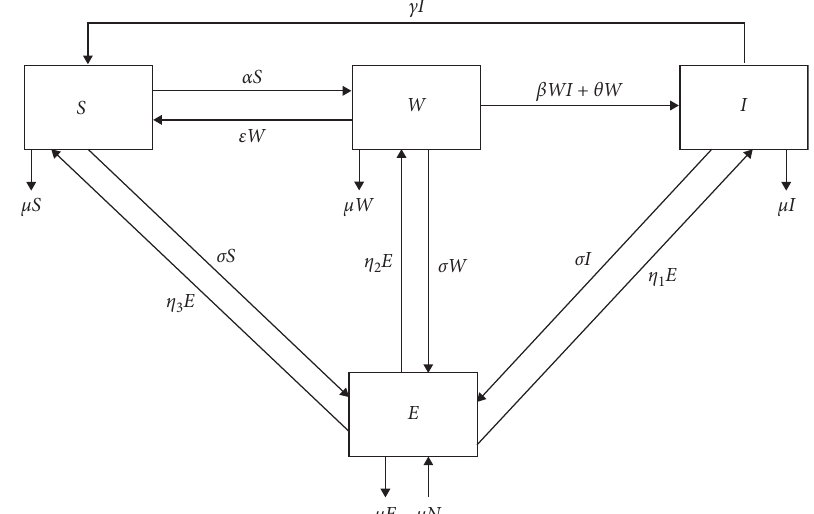
Figure 1: The transfer diagram of the model.